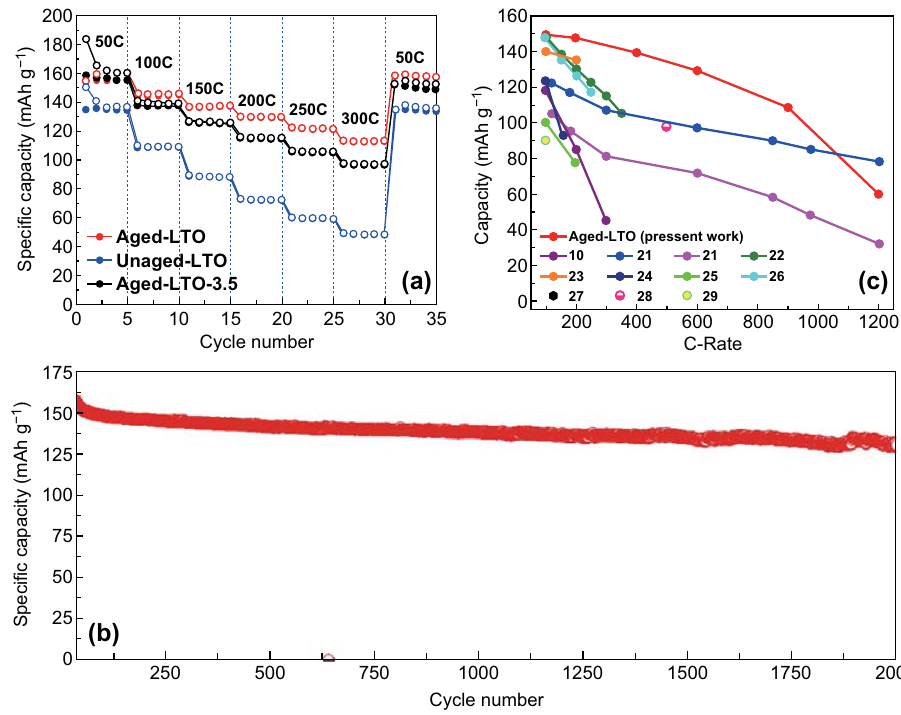
Fig. 3 Electrochemical performances of the half cells. a Ultrahigh-rate performances of the aged and unaged LTO electrodes at rates shown in the legend. b Long-cycling performance of the aged LTO sample at 50 C . c Rate performance of the aged LTO sample up to 1200 C and high-rate LTO literature